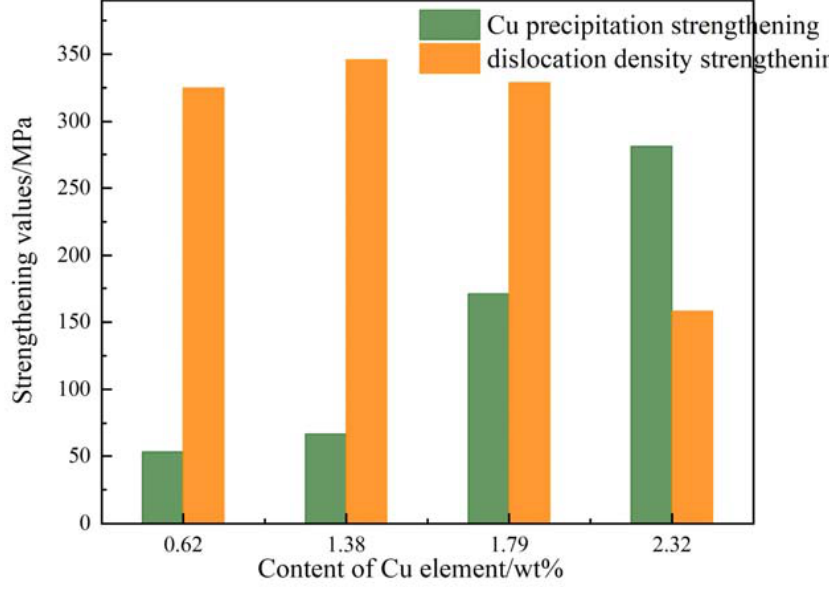
Figure 13. Contributions of precipitation strengthening and dislocation strengthening of deposited metals. The Cu 1.79 obtains the best yield strength due to the high dislocation density and Cu pre ‐ cipitation.